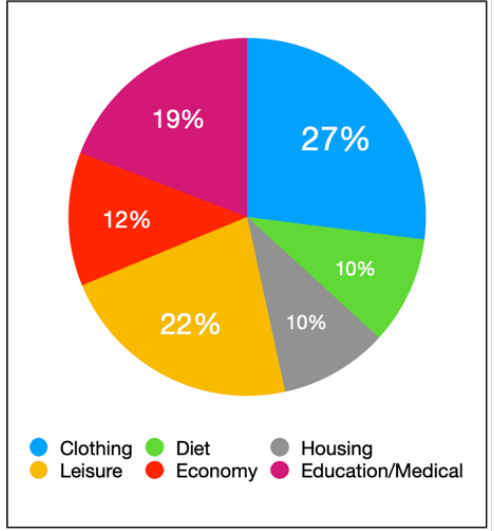
Figure 2. DH use rate in lifestyle categories.